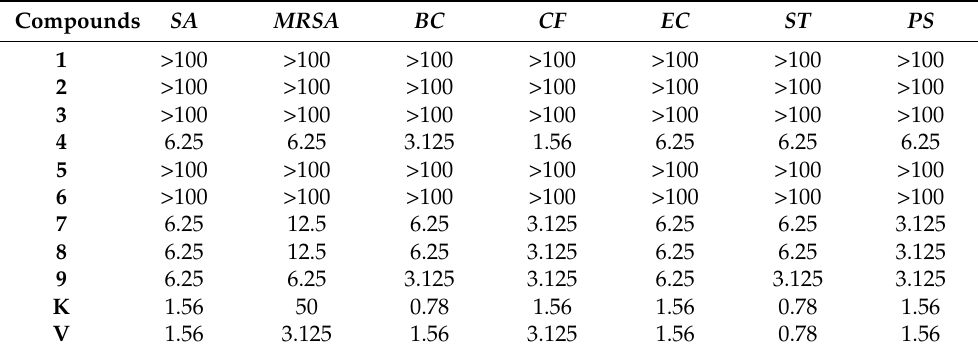
Table 3. Antibacterial activity of compounds 1 – 9 (MIC, µ g/mL). Compounds